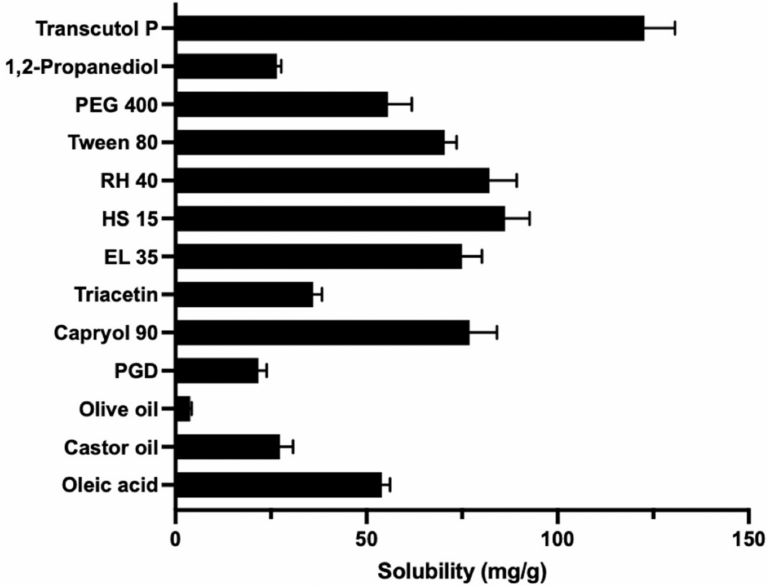
Figure 1. The solubility of LCZ in different oils, surfactants and co-surfactants (mean ± SD, n =